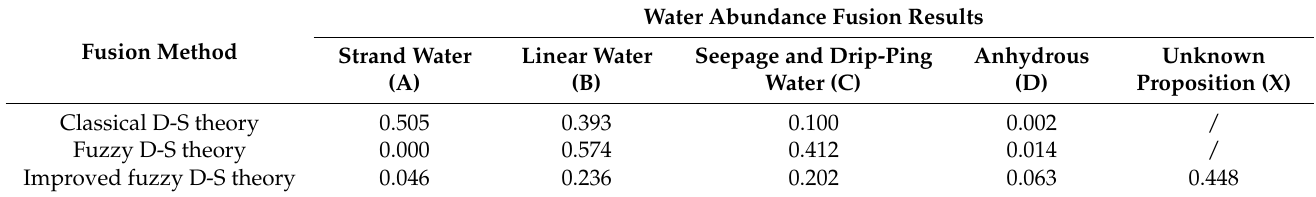
Table 6. Fusion results from the three different